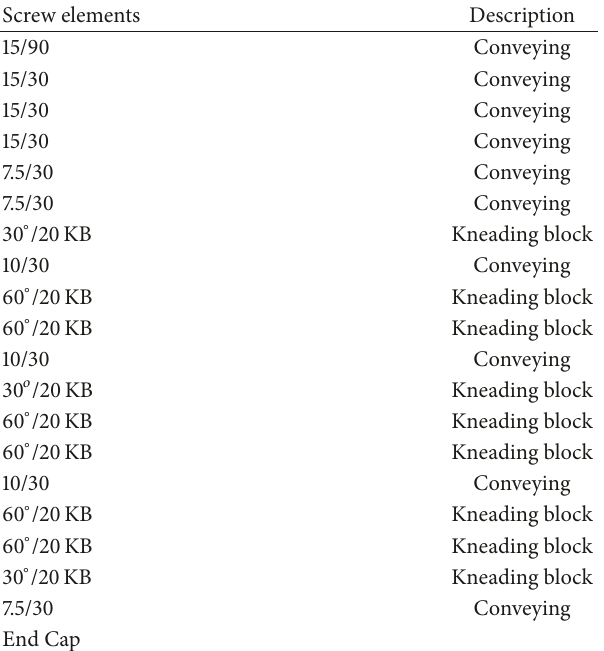
Table 2: Screw configuration for Leistritz twin-screw extruder. Screw